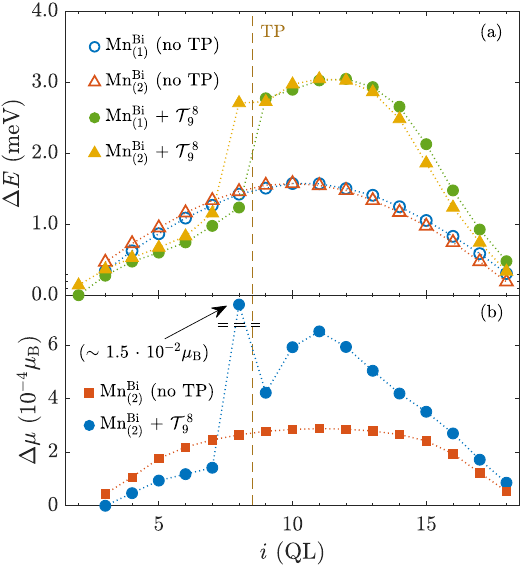
Figure 8. Magnetic doping of one layer inside the Bi 2 Se 3 multilayer. ( a ) Relative formation energy of Mn Bi substition defects as a function of the doped QL i . Mn Bi ( and Mn Bi ( stand for substitutions at 1 ) 2 ) distinct Bi sites. Mn Bi ( faces neighbouring QL with lower x . Dependencies with and without TP are 1 ) depicted. For clarity, they are shifted to fit at the end points. ( b ) Distribution of magnitudes of Mn Bi magnetic moments as a function of the position of the substitution i . Only one Bi site labeled by the index i of the appropriate QL is doped by 1% of